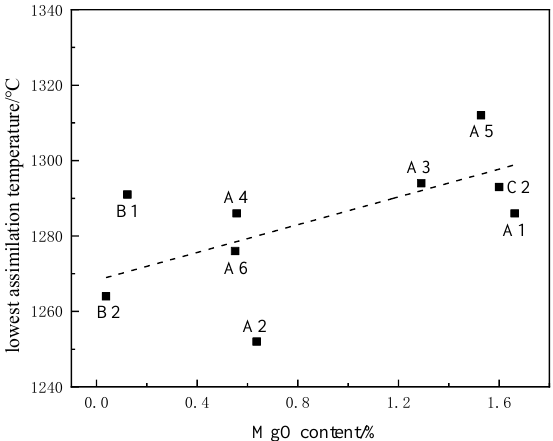
Figure 8. Influence of MgO content on assimilation temperature.